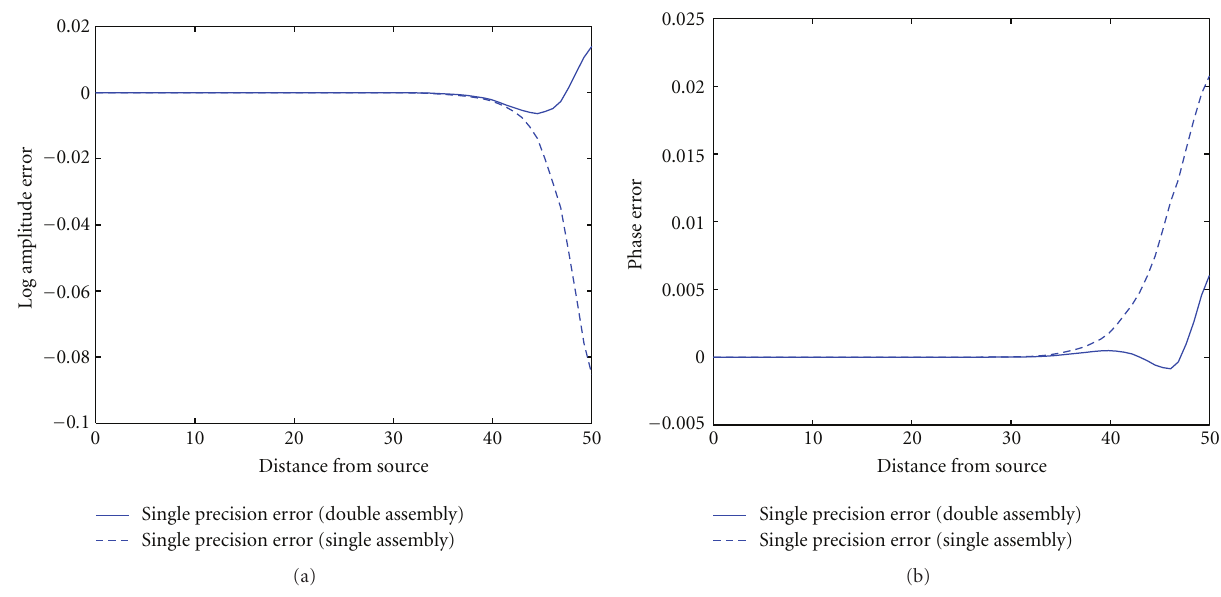
Figure 3: E ff ect of single-precision arithmetic on forward solutions. Shown are the di ff erences between single and double precision solutions for logarithmic amplitude (a) and phase (b) of the complex field computed in a cylindrical domain along a line from the source across the cylinder. The solid line shows the solution error for a system matrix assembled in double precision and solved in single precision while the dashed line represents the solution for a system matrix assembled and solved in single precision.